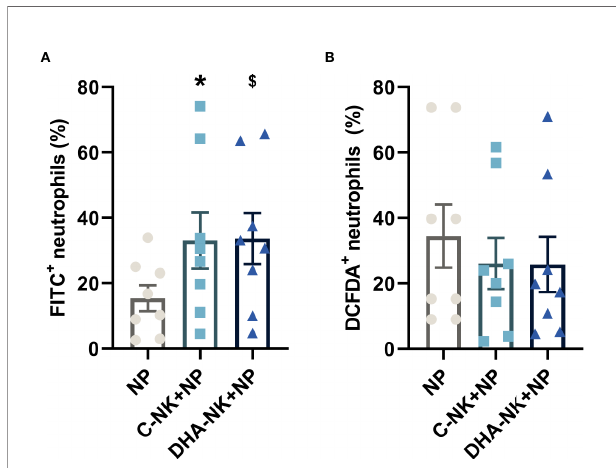
FIGURE 4 | The effects of NK cells and NK cells pre-incubated with DHA on neutrophil phagocytosis (A) and reactive oxygen species production (B) . Neutrophils were cultured alone (NP) or with NK cells that had been pre- incubated for 18 h without (C-NK+NP) or with 50 µM docosahexaenoic acid (DHA-NK+NP) and then stimulated with IL-2 (2 ng/ml), IL-12 (2 ng/ml), and IL- 15 (10 ng/ml). The cells were cultured together for 6 h. Phagocytosis was determined by fl ow cytometric analysis of engulfed FITC-labelled E. coli and presented as percent of the total granulocyte population (A) . Reactive oxygen species production was measured by DCFDA conversion to the highly fl uorescent 2 ′ ,7 ′ -dichloro fl uorescein, determined by fl ow cytometry and presented as percent of the total neutrophil population (B) . Positive gating was determined by appropriate untreated controls. Data are shown as mean ± SEM; * indicates difference between C-NK+NP and NP and $ difference between DHA-NK+NP and NP. One symbol indicates p < 0.05. n = 8 (independent donors), collected in three independent experiments.